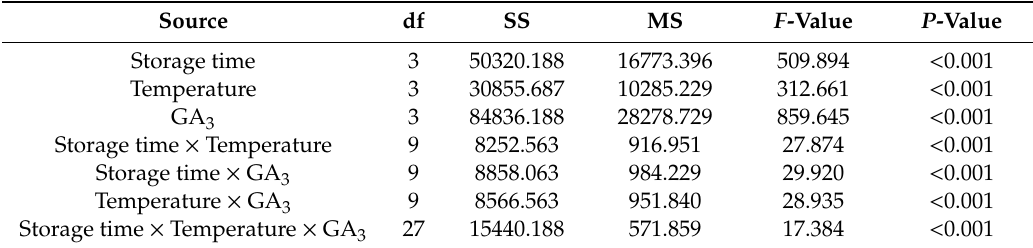
Table 3. Three-way ANOVA results testing the e ff ects of storage time, GA 3 , temperature and their interactions on germination of Lepidium apetalum seeds stored dry for 1, 2, and 3 months. df, degree of freedom; MS, mean square; SS, sum of squares.